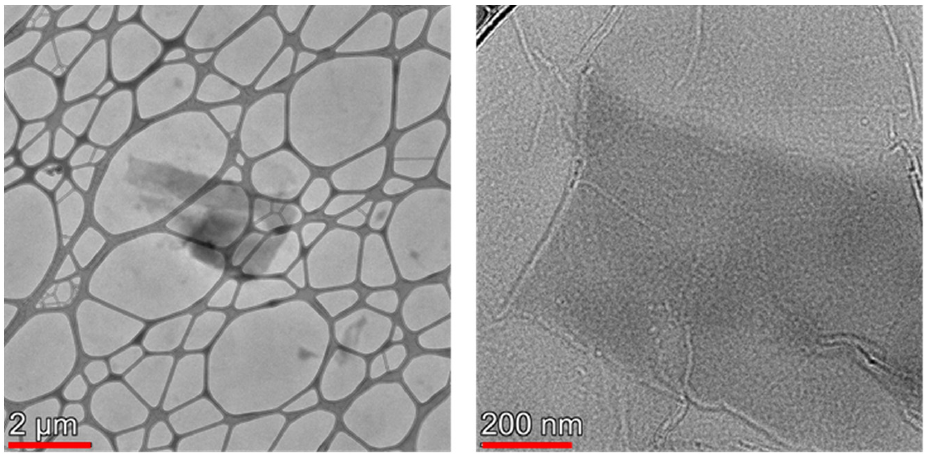
Figure 1. TEM images of the GO particles. The scale bar is 2 µm and 200 nm on the left- and right-hand side, respectively.